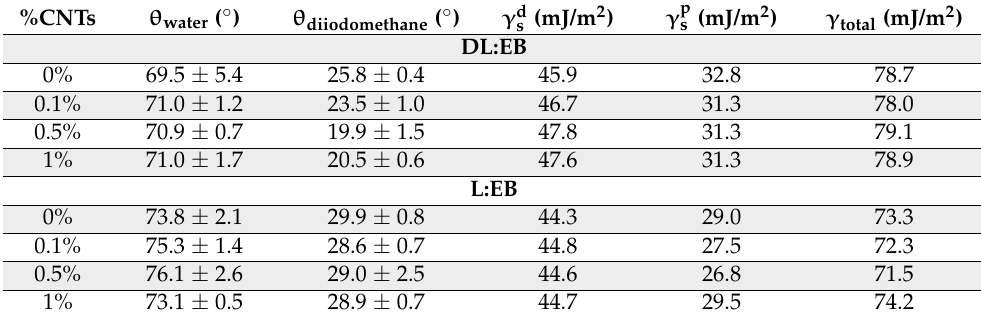
Table 5. Contact angle measurements with water and diiodomethane as liquid